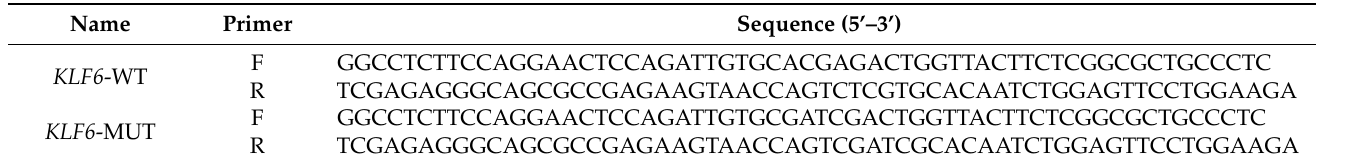
Table 2. Primer sequences for dual-luciferase reporter